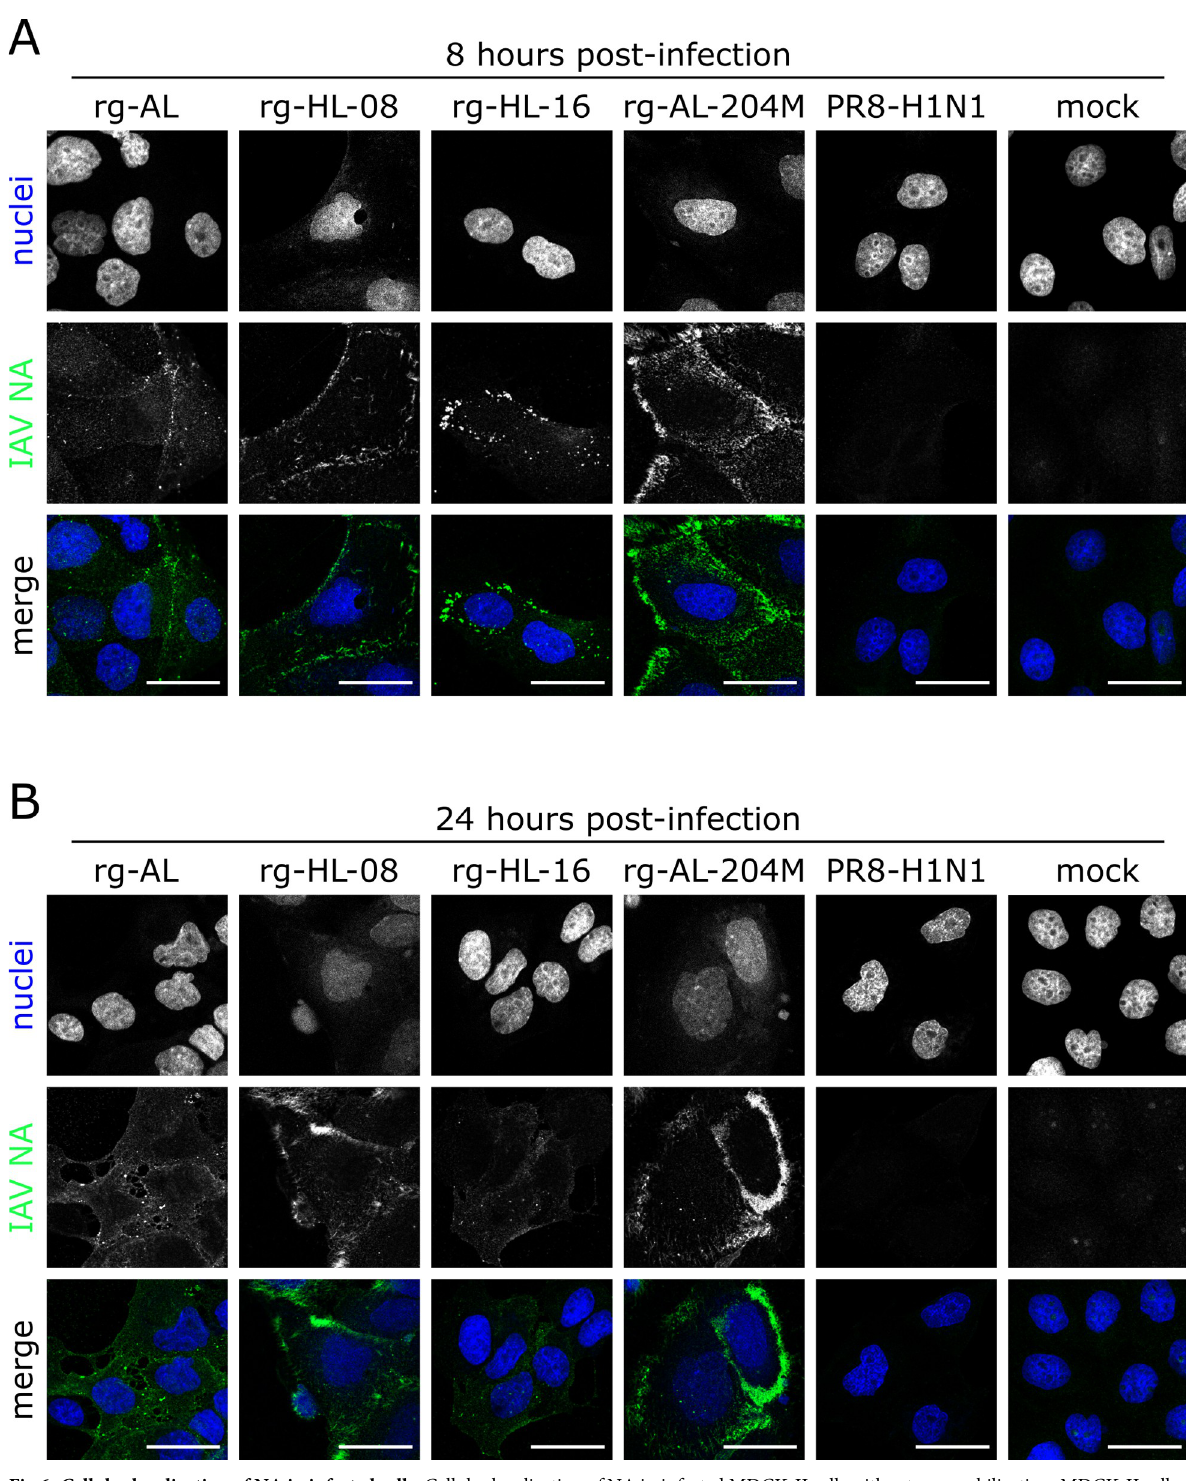
Fig 6. Cellular localization of NA in infected cells. Cellular localization of NA in infected MDCK-II cells without permeabilization. MDCK-II cells were infected with indicated viruses with an MOI of 1 for 8 (A) and 24 h (B). Cells were fixed and analyzed via confocal microscopy. Cell nuclei were counterstained with Hoechst33342. NA was detected by rabbit anti-N1 polyclonal antibodies. Confocal images were acquired with a Leica DMI6000 TCS SP5 confocal laser-scanning microscope (Leica Microsystems, Germany). Representative images of three independent experiments were processed using arivis vision4D (v3.4.0). Scale bar: 25 μ m.